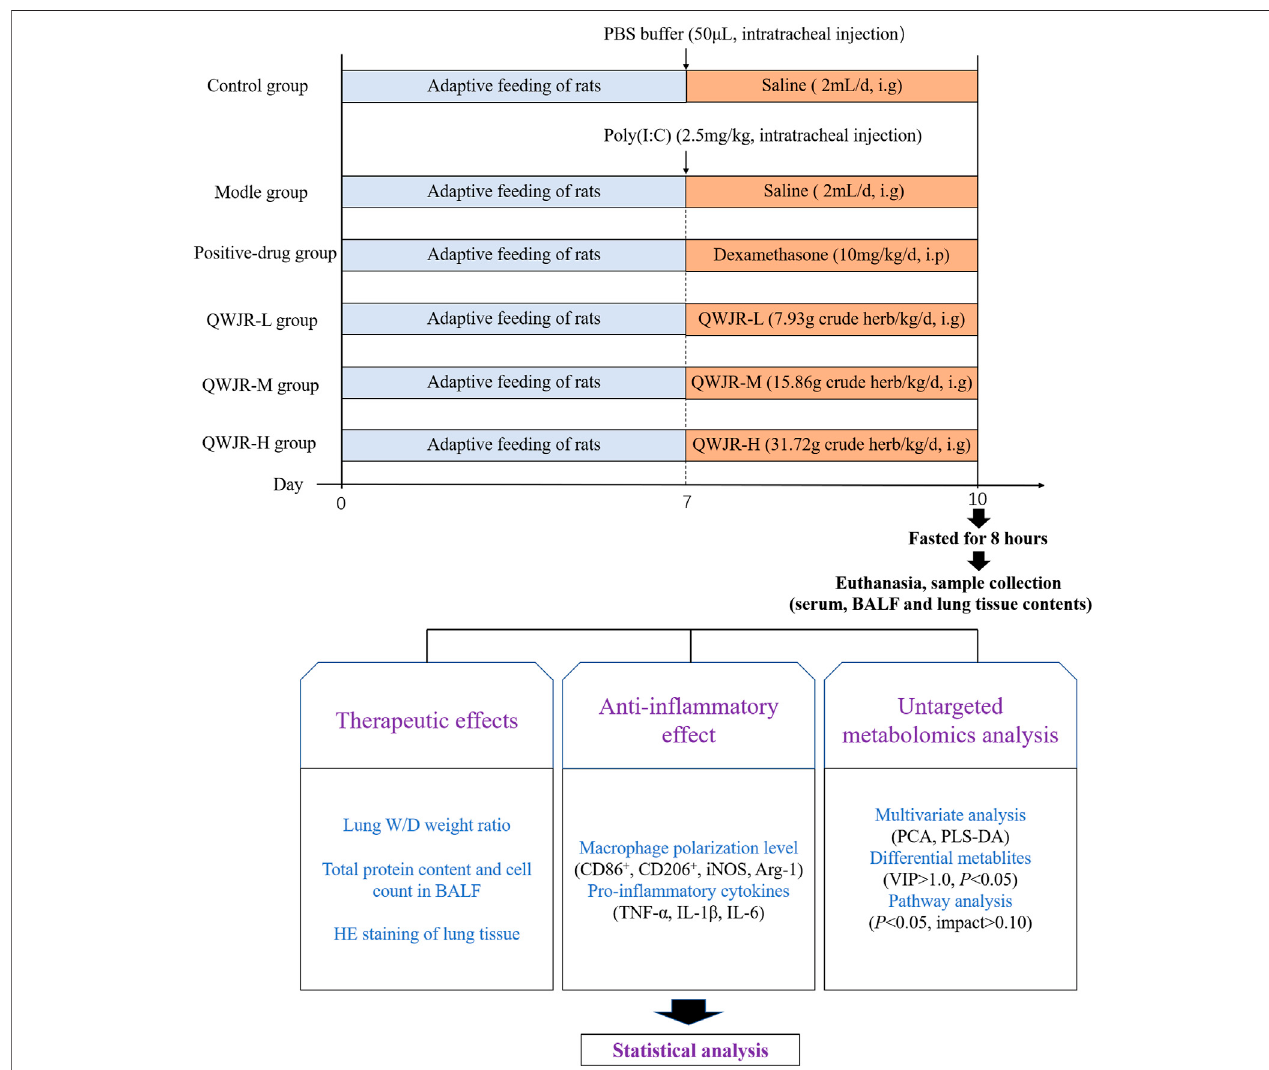
FIGURE 1 | Overview of the experimental design for all groups.